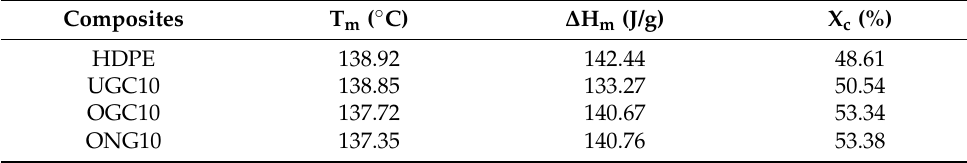
Figure 4. DSC curves of HDPE (smooth line), UGC10, OGC10 and ONGC10. Table 7. Summary of DSC data of HDPE, UGC10, OGC10 and ONGC10.